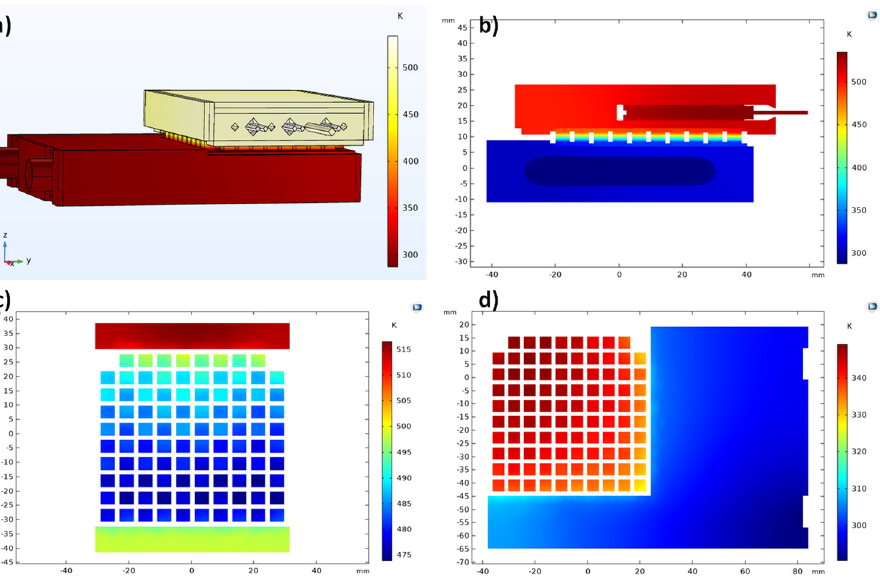
Figure 8. ( a ) Temperature distribution across the testing system when using the silicide-tetrahedrite TEG with a conventional geometry; ( b ) temperature distribution from a vertical plane cut taken from the middle of the plate; ( c ) temperature distribution on the top of the TEG legs (hot zone); ( d ) temperature distribution on the bottom of the TEG legs (cold zone).